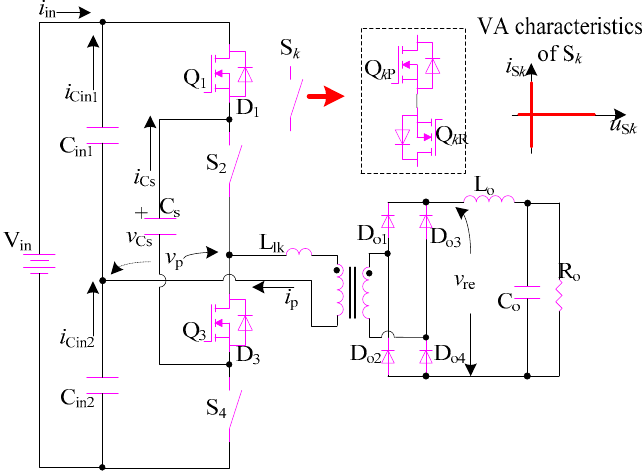
Figure 2. Proposed capacitor-clamped ZVZCS HB TLDC.